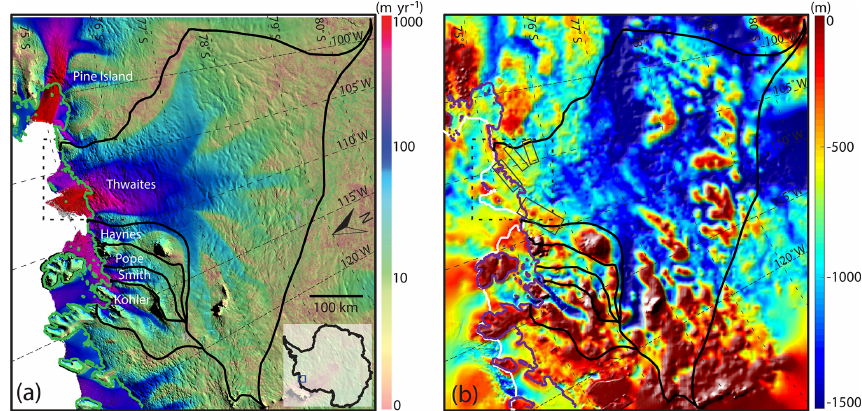
Figure 1. (a) Surface velocity of Thwaites Glacier, West Antarctica, derived from satellite radar interferometry (Rignot et al., 2011b). (b) Bed elevation of Thwaites Glacier and surrounding sea floor (Morlighem et al., 2011; Millan et al., 2017). The green line in (a) and purple line in (b) are the grounding line positions of all the glaciers in the region (Rignot et al., 2011a). The black contours are the boundaries of the drainage basins. The white line in (b) is the ice front position. The black dashed box in (a) is the region shown in Fig. 4. The gray boxes in (b) denote four subglacial ridges near the current grounding line of